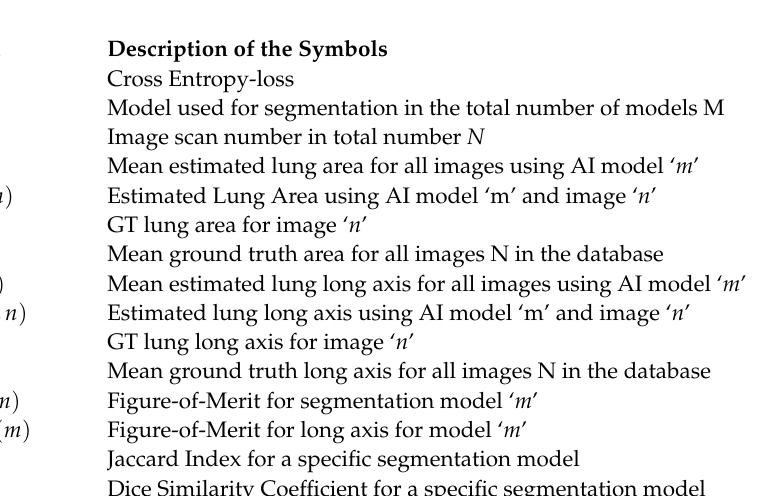
Figure-of-Merit for segmentation model ‘ m ’ Figure-of-Merit for long axis for model ‘ m